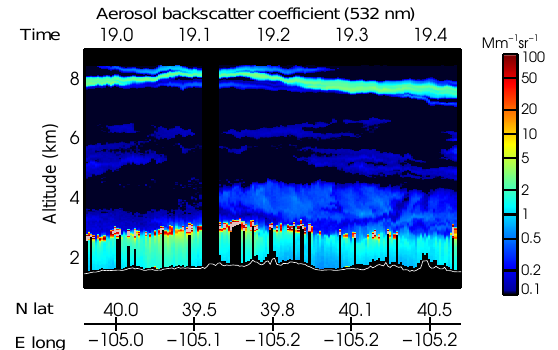
Figure 12. 532nm aerosol backscatter coefficient measurement cur- tain from HSRL-2 for a portion of a flight on 17 July 2014 in and around Denver, Colorado. Approximately the first third of the pictured curtain is a southbound track between the Boulder At- mospheric Observatory Tall Tower and Chatfield State Park, CO. The remainder of the flight is a northbound leg between Chatfield State Park and Fort Collins. The blank region indicates a tight turn at Chatfield State Park where the lasers were shuttered. Scattered clouds are visible at the top of the boundary layer. Some of these have off-scale backscatter values (tan color) and some are thick enough to cause significant attenuation of the beam; beneath these, data are blanked out due to low signal. The white line indicates underlying terrain. The smoke layer at approximately 8km is dis- cussed in the